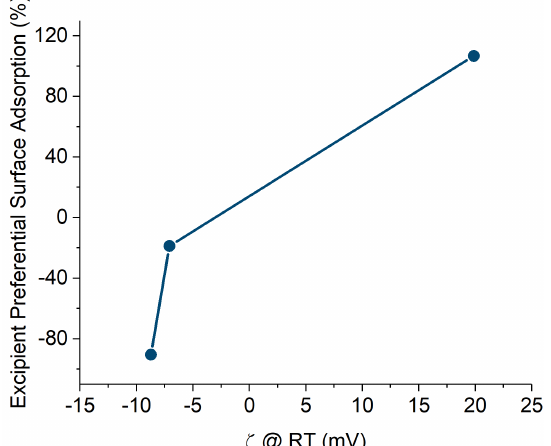
Figure 7. Relationship between functionalisation-induced changes to excipient ζ and preferential adsorption. Nanoparticles of unfunctionalised (hydroxyl), aminopropyl, and octyl surface moieties were compared. The zeta potential values for these particles in feed buffer (pH 5.5) were − 8.7, 19.9, and − 7.1,